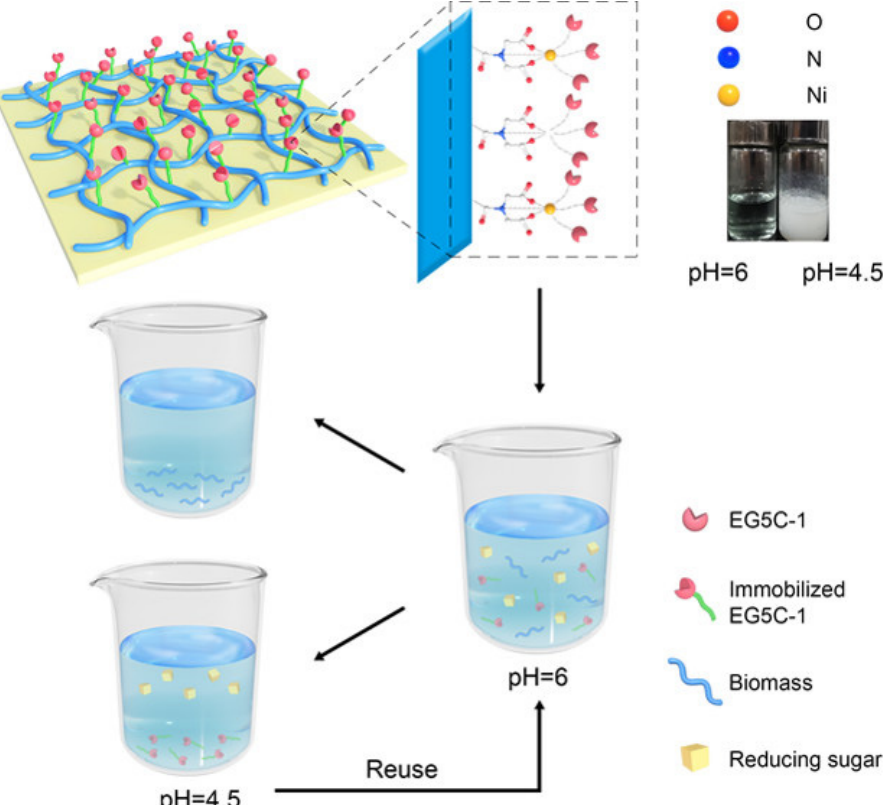
Figure 10. Schematic representation of the recyclable Eud-IDA-Ni 2+ /EG5C-1 biocomposite which is soluble at pH above 5.5 and insoluble for separation at pH below 4.5, can effectively hydrolyze cellulose. Reproduced with permission from [141], American Chemical Society, 2021.